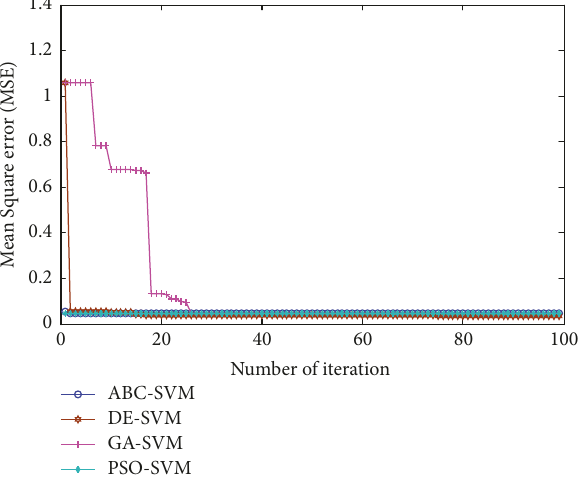
Figure 4: Marching steps for optimization of MSE for modeling Ra of TC18 titanium